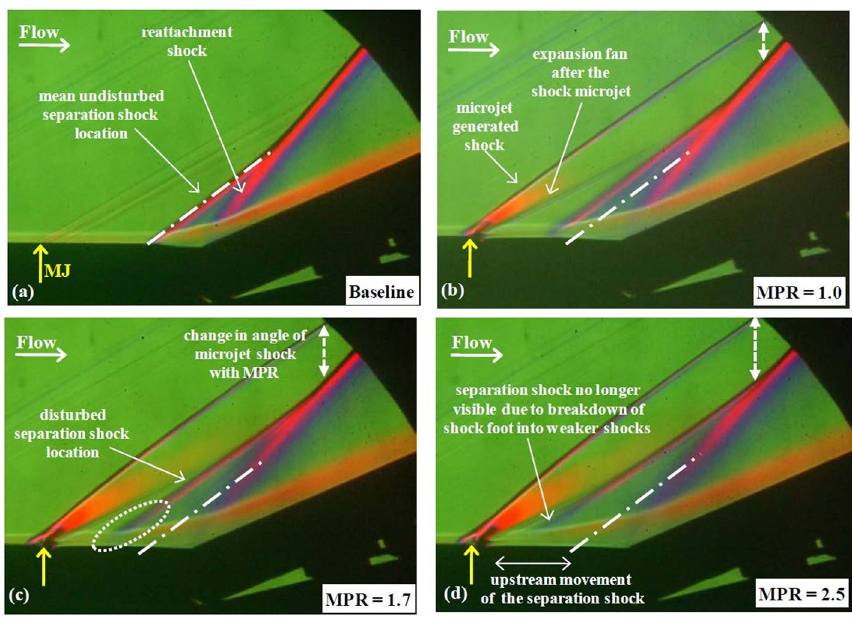
Fig. 5 Schlieren flow visualization describing the effect of control with the variation of Microjet